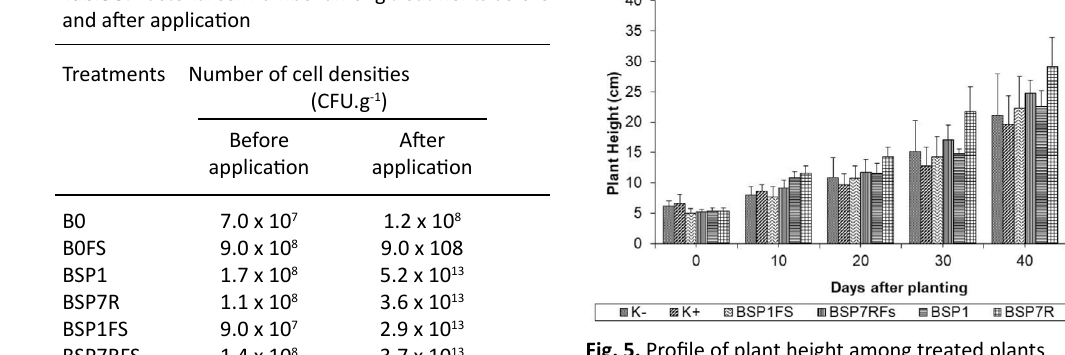
Fig. 5. Profile of plant height among treated plants